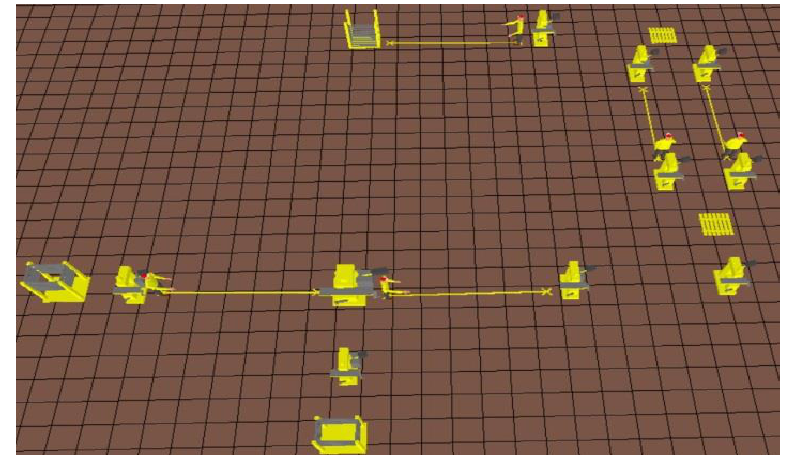
Figure 3: Manual handling